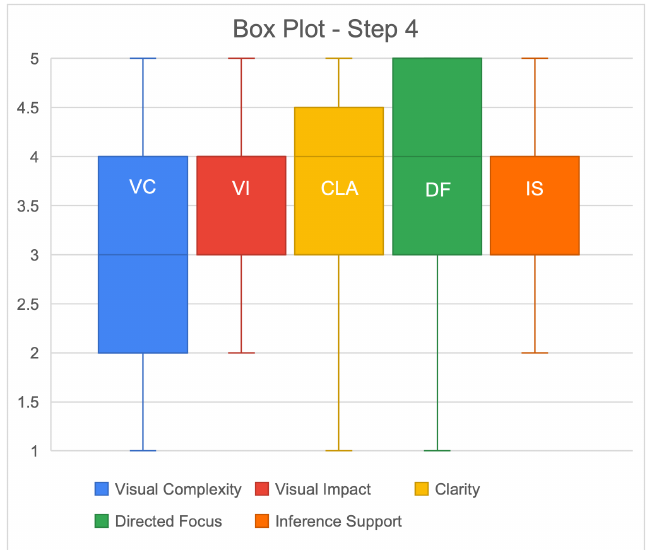
Figure 8. Boxplot chart for the results associated with the visual characteristics of Step 4 instructions— reach in and remove the